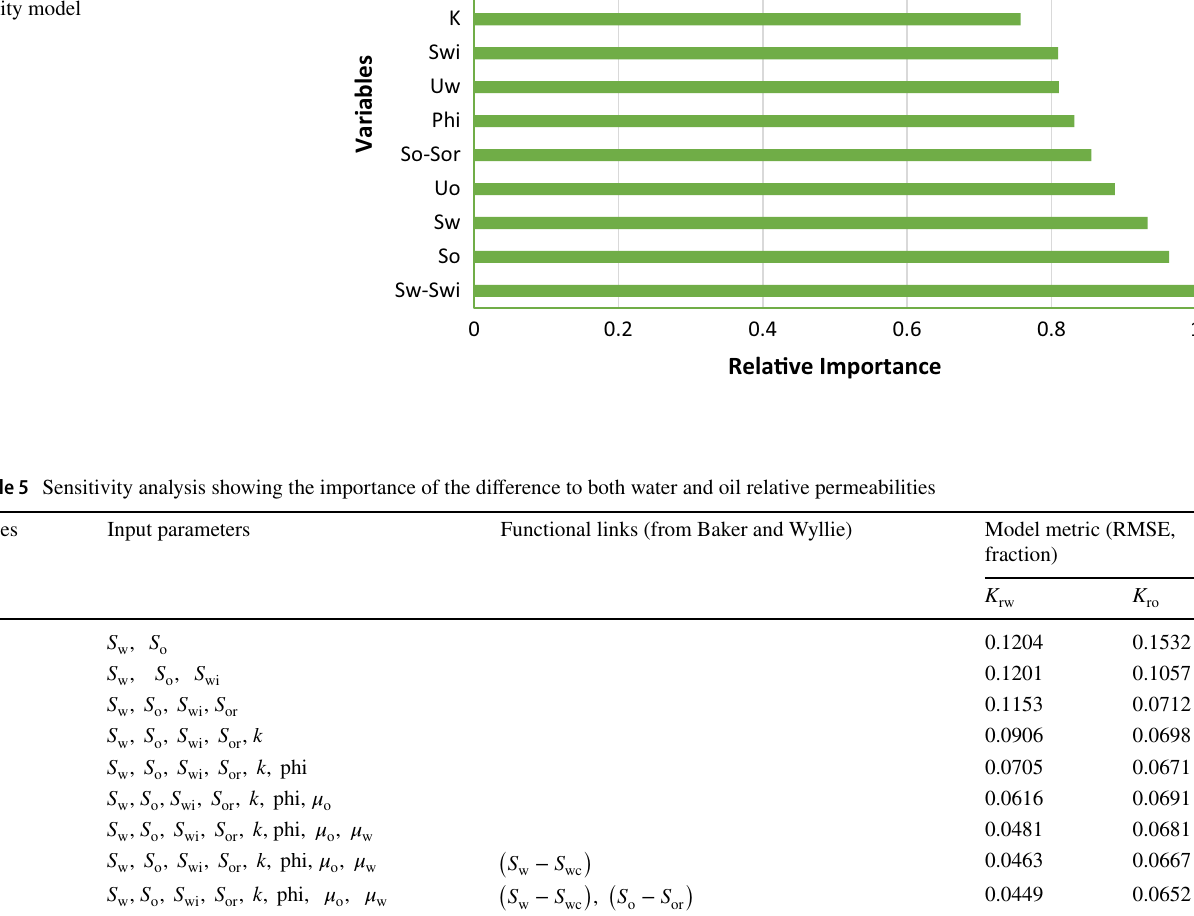
Fig. 14 Sensitivity analysis of individual variable used for building the non-wetting phase deep learning relative perme- ability model